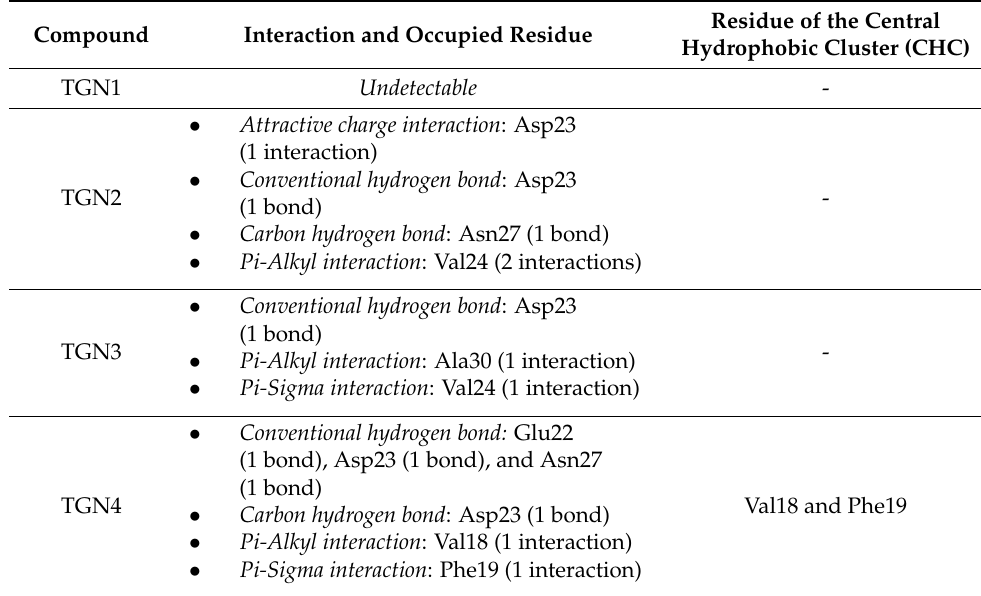
Table 3. List of amino-acid residues occupied by the compounds.